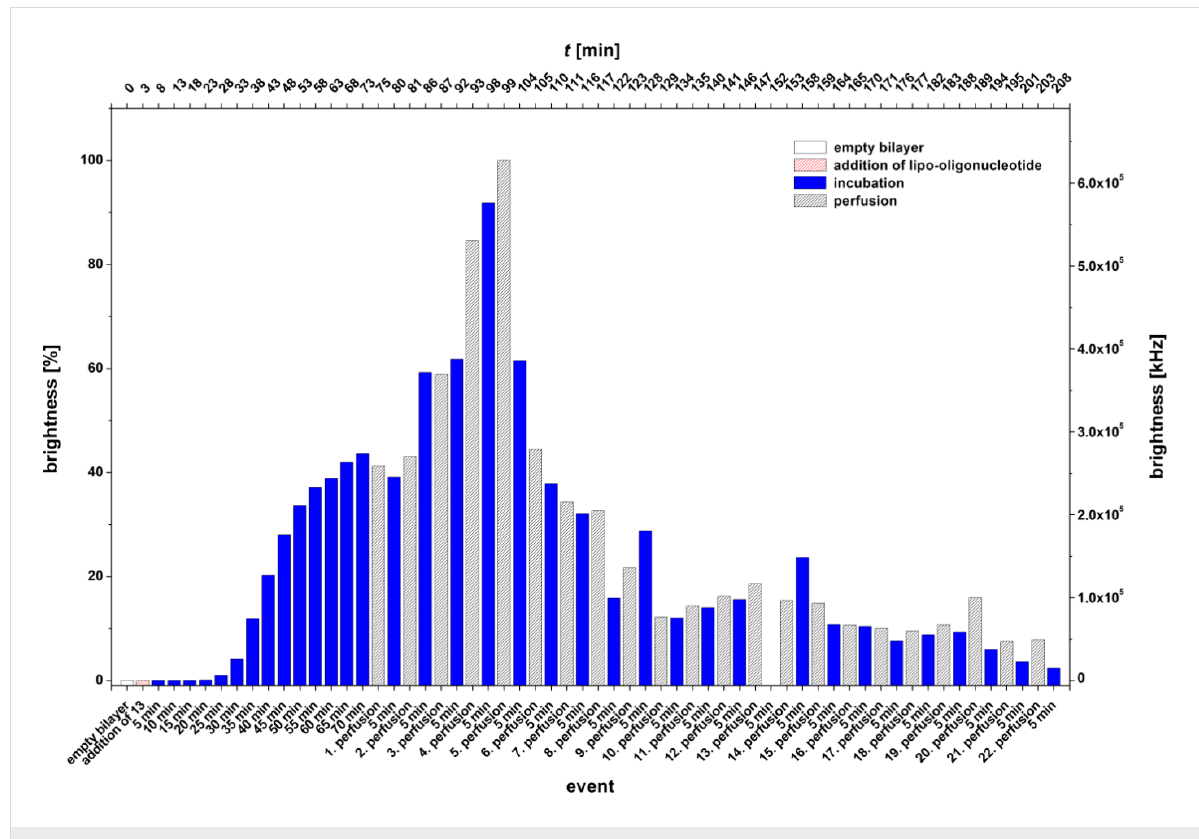
Figure 8: Bilayer brightness vs event graph of 5’-d( 7a -Cy5-TAG GTC AAT ACT) ( 13 ).